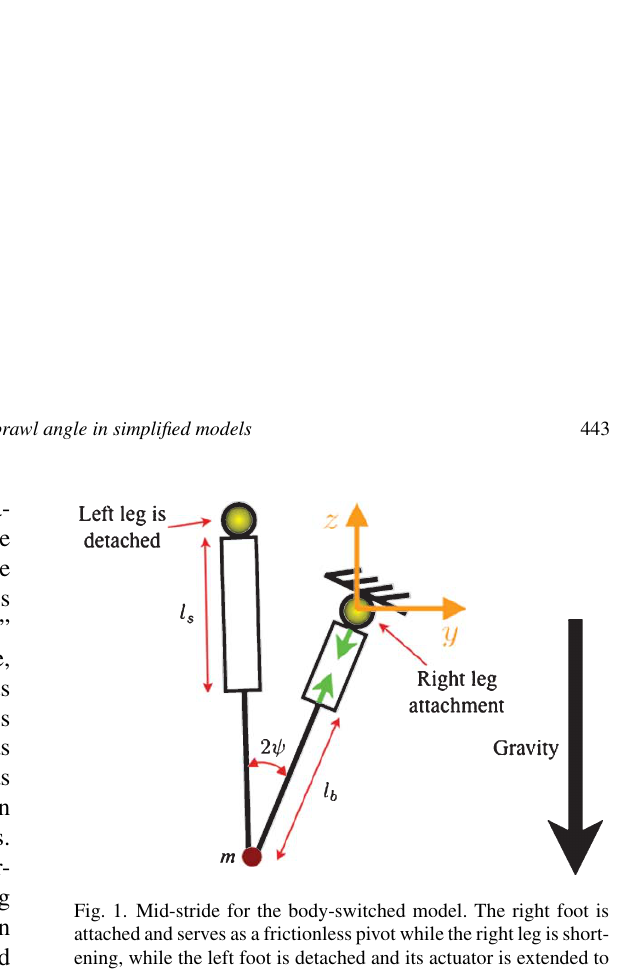
This model and the Full-Goldman template